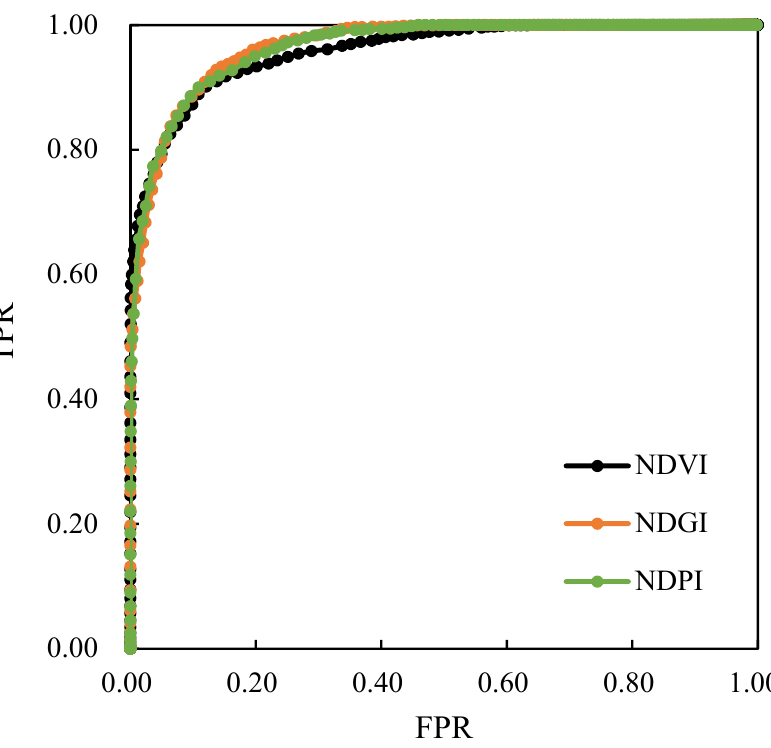
Table 2. Optimal thresholds ( T ), error indices, and accuracy.